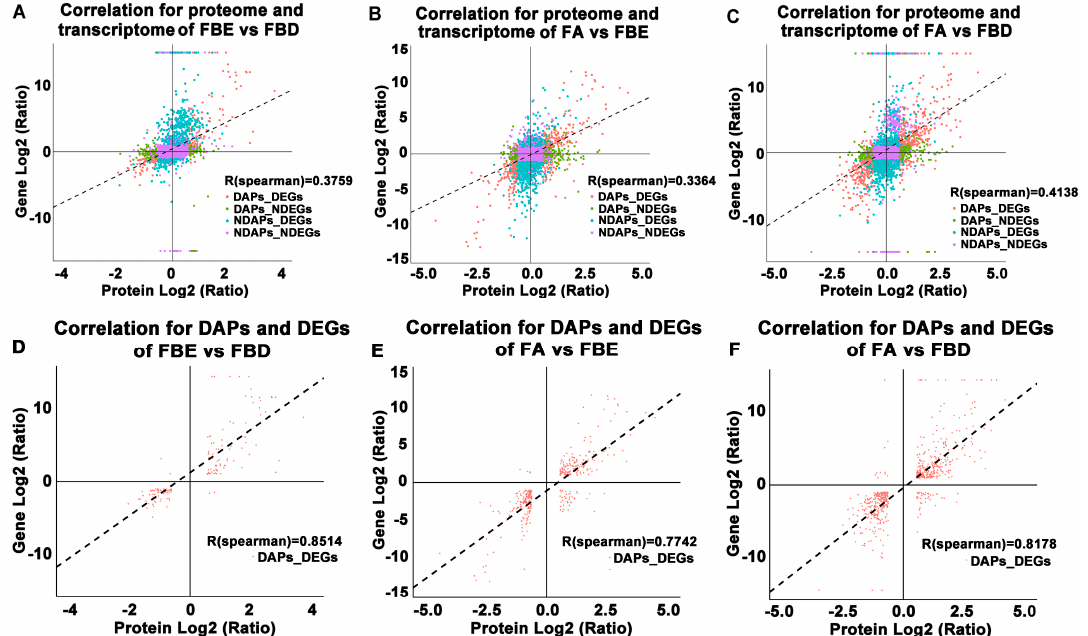
Figure 8. Correlation for proteome and transcriptome, differentially accumulated proteins (DAPs), and DEGs of FBE vs. FBD, FA vs. FBE, and FA vs. FBD. ( A – C ) Correlation for proteome and transcriptome of FBE vs. FBD, FA vs. FBE, and FA vs. FBD. ( D – F ) Correlation for DAPs and DEGs of FBE vs. FBD, FA vs. FBE, and FA vs. FBD.